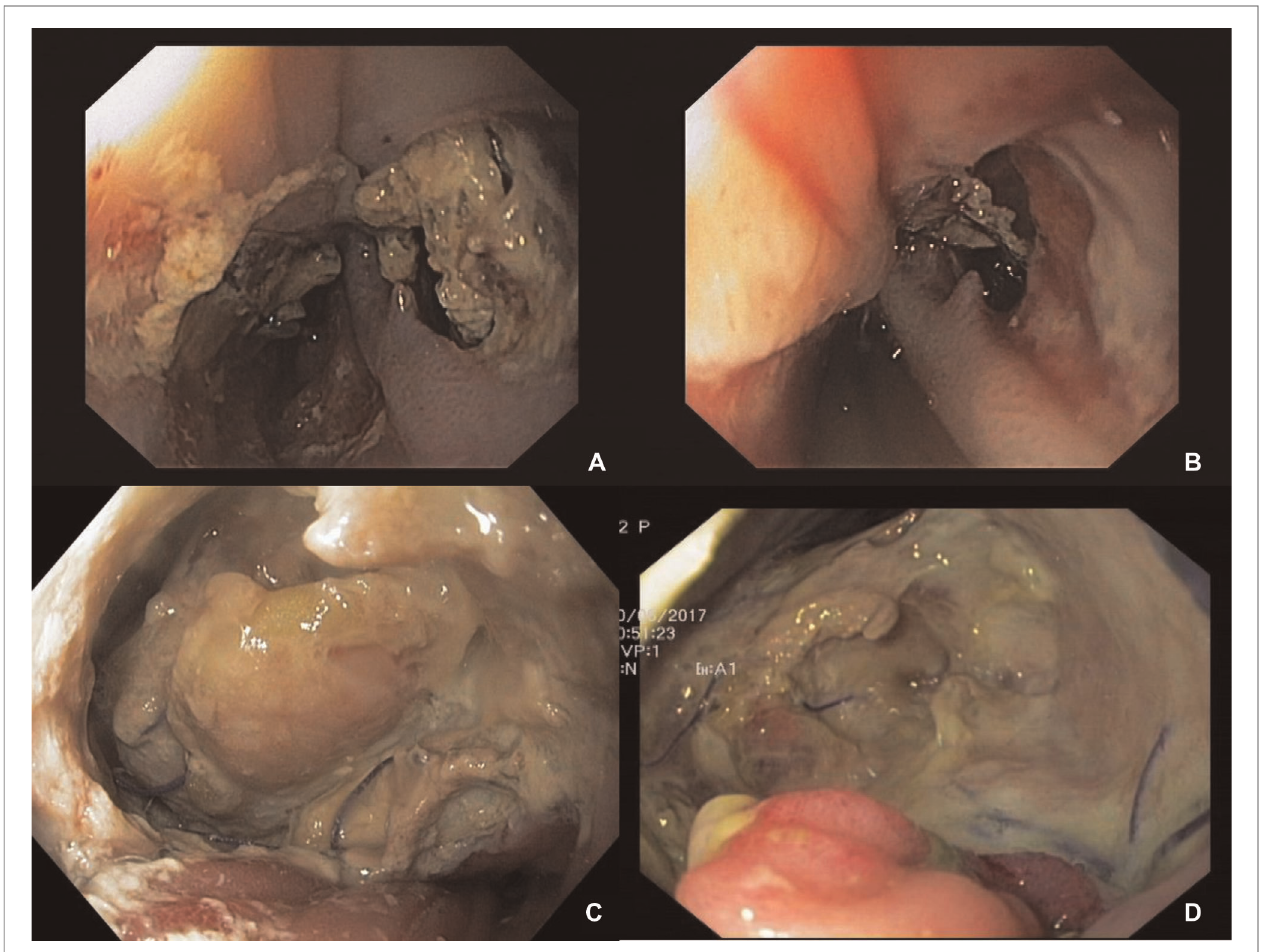
FIGURE 5 | ( A – D ) Endoluminal view of an esophageal defect with tissue necrosis. Initial necrosis ( A , C ) and condition after necrosectomy ( B , D ). It can be seen after necrosectomy that the transmural portion of necrosis is smaller than initially